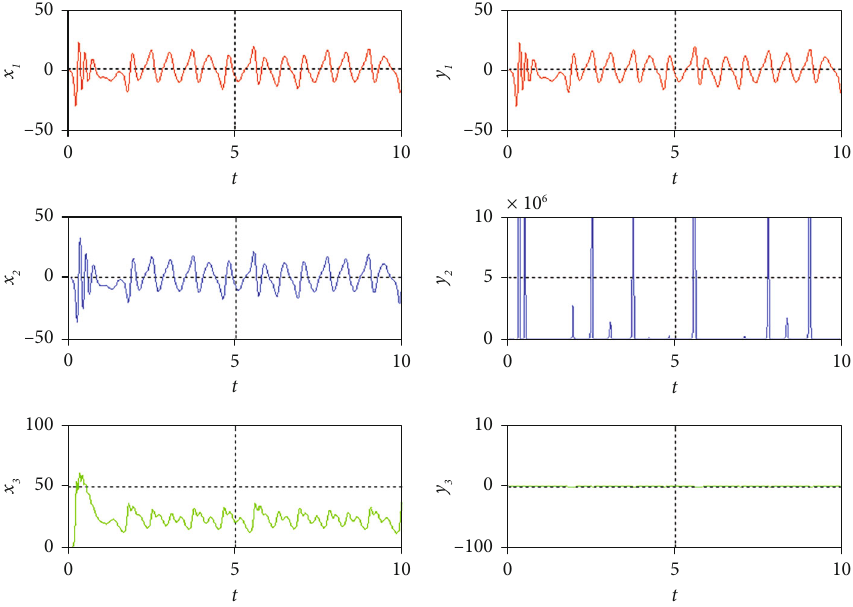
Figure 8: Time histories of di ff erent state variables in the unidirectionally coupled Chen system with the exponential manifold y = ½ x , e x 2 , e − x 3 (cid:2) T 1